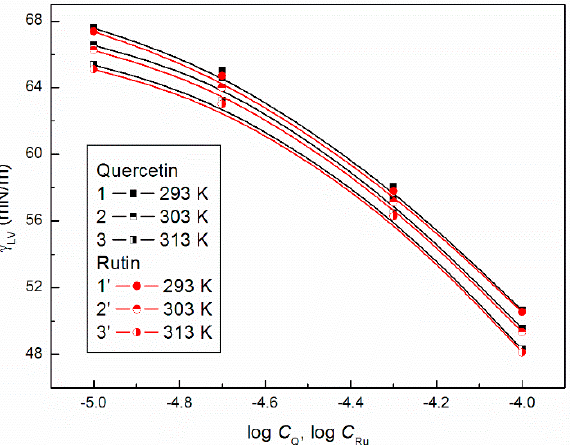
Figure 1. A plot of the surface tension ( γ LV ) of the aqueous solutions of quercetin (curves 1–3) and rutin (curves 1 ′ –3 ′ ) vs. the logarithm of their concentration (log C Q and log C Ru ) at the temperatures equal to 293 (curves 1 and 1 ′ ), 303 (curves 2 and 2 ′ ) and 313 K (curves 3 and 3 ′ ), respectively. In the literature it is difficult to find the surface tension of the quercetin and rutin.